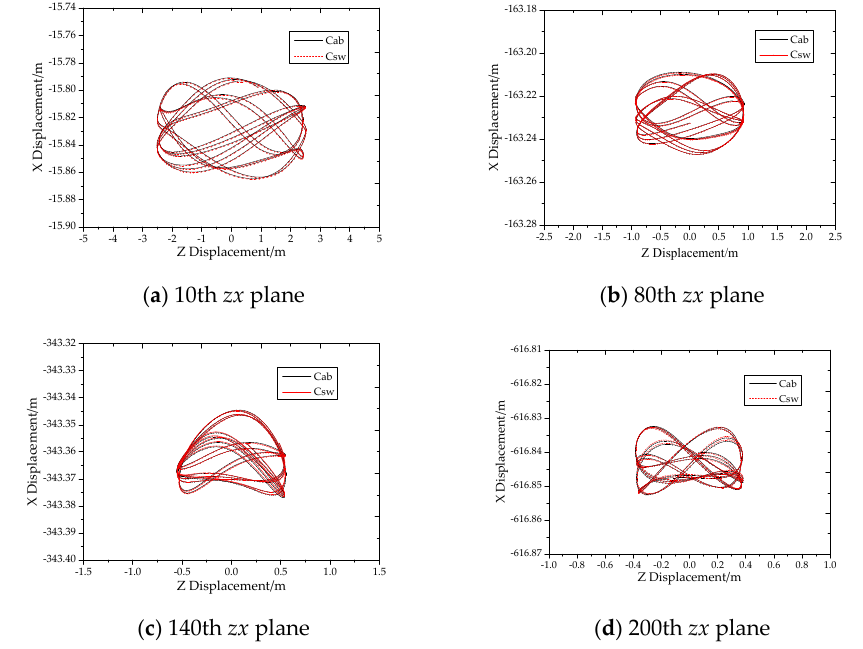
Figure 5. Lissajous phenomenon of 10th – 200th in the zx plane.